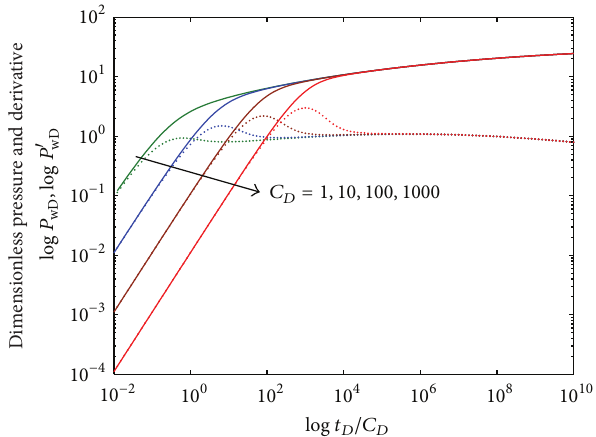
Figure 5: Effect of 𝑑 𝑓 for the type curves of the fractal reservoir with spherical flow.